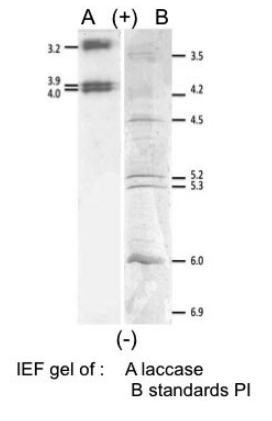
Figure 3. SDS-PAGE and IEF of purified laccase from Fomitiporia